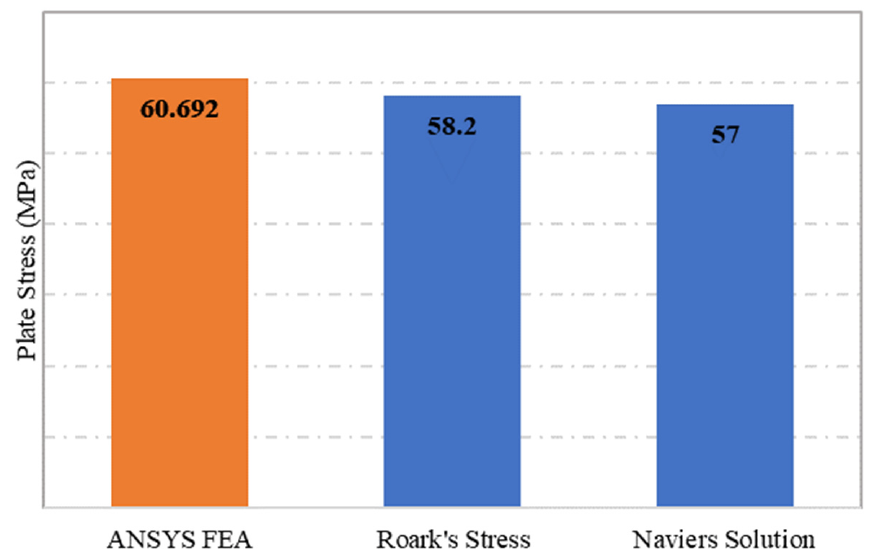
Figure 4. Plate maximum stress comparison between ANSYS FEA, Roark’s stress and Navier solu- tion.